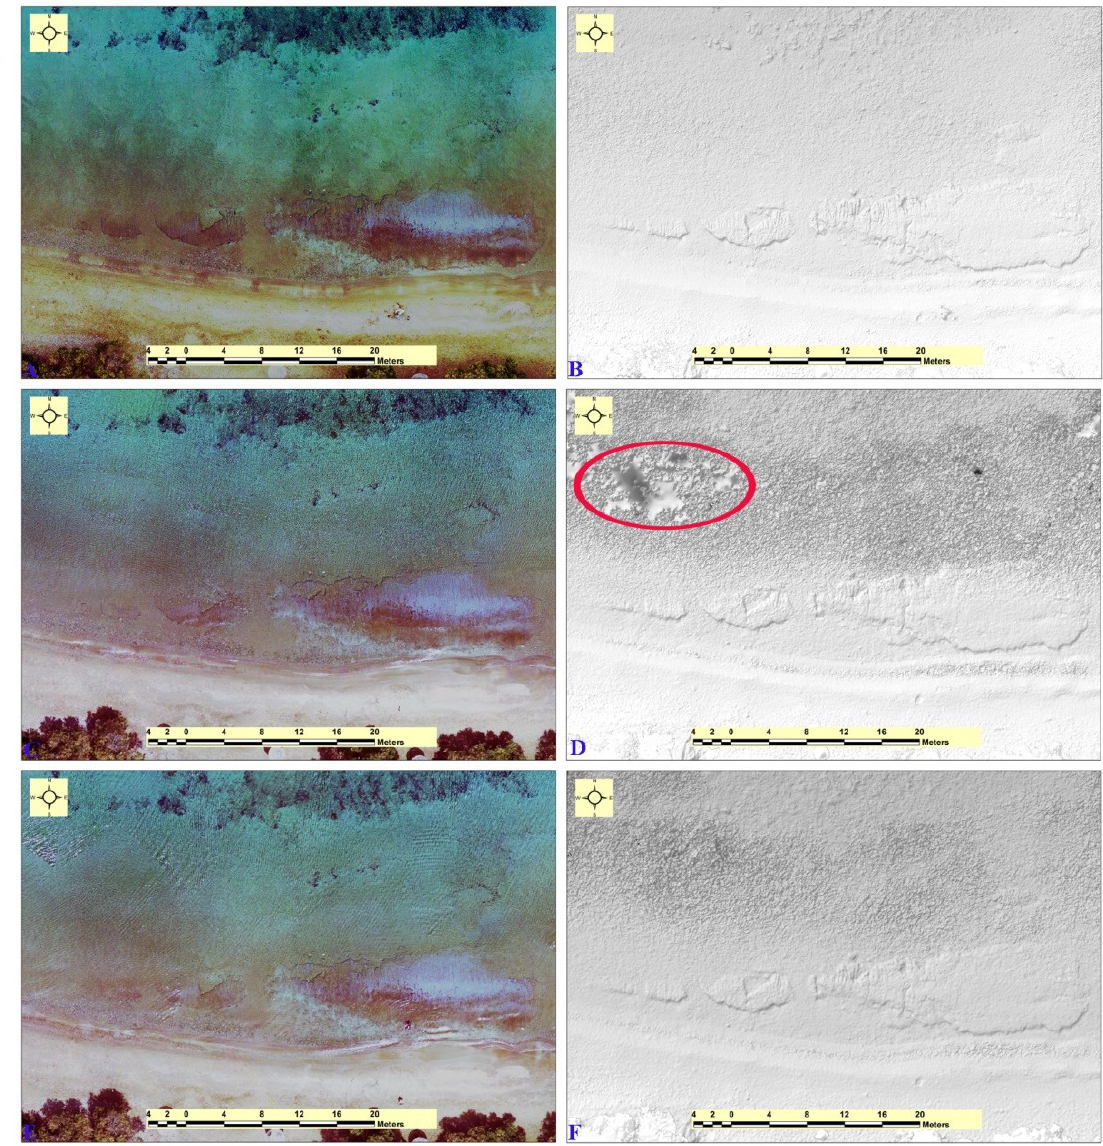
Figure 3. ( A ) Orthophoto of the UAV flight at 20 m agl. ( B ) The respective DSM. ( C ) Orthophoto of the UAV flight at 25 m agl. ( D ) The DSM from the UAV flight at 25 m agl. The red ellipse marks an artefact inside the DSM. ( E ) Orthophoto of the UAV flight at 30 m agl. ( F ) The respective DSM from the flight at 30 m. Due to the light waves that can be detected in Figure 3E, the quality of the DSM in Figure 3F is quite low. However, the beachrock can still be outlined.